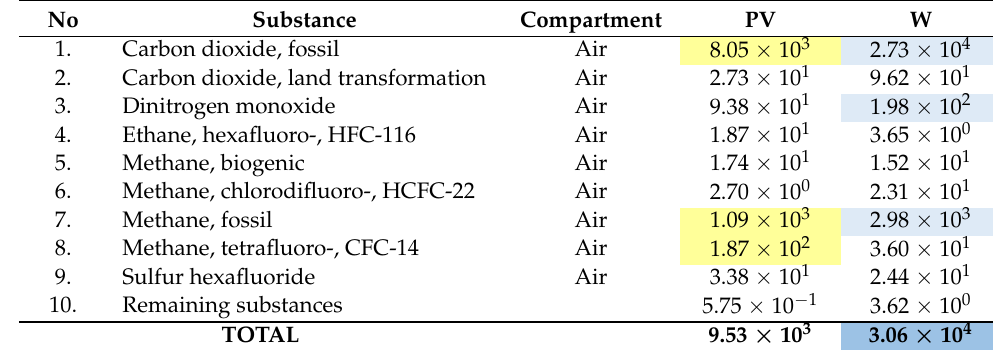
Table 2. Grouping and weighting results of environmental effects for global warming, human health present in the life cycle of wind (W) and photovoltaic (PV) power plants (unit: Pt). No Substance